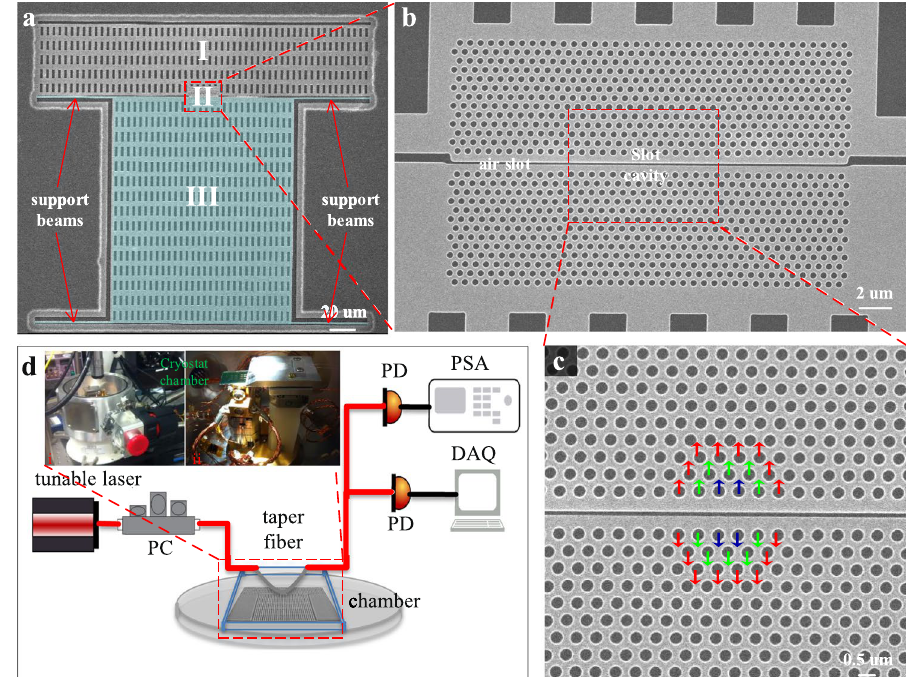
Figure 1. Optomechanical cavity oscillator with large moveable mass. ( a ) Scanning electron micrograph (SEM) of nanofabricated large mass silicon optomechanical oscillator. Region I: stationary part, Region II: slot cavity part, and Region III: test-mass part. Scale bar: 20 μ m. ( b ) Zoom-in SEM of the photonic crystal optomechanical device. Scale bar: 2 μ m. ( c ) Zoom-in SEM of the photonic crystal slot cavity with hole perturbation shifts denoted in color. Red: 5 nm, green: 10 nm, blue: 15 nm. Scale bar: 500 nm. ( d ) Measurement setup. PD: photo detector, PSA: Power Spectrum Analyzer, PC: polarization controller, and DAQ: Data Acquisition. Inset is the image of the vacuum chamber and 5-axis Attocube